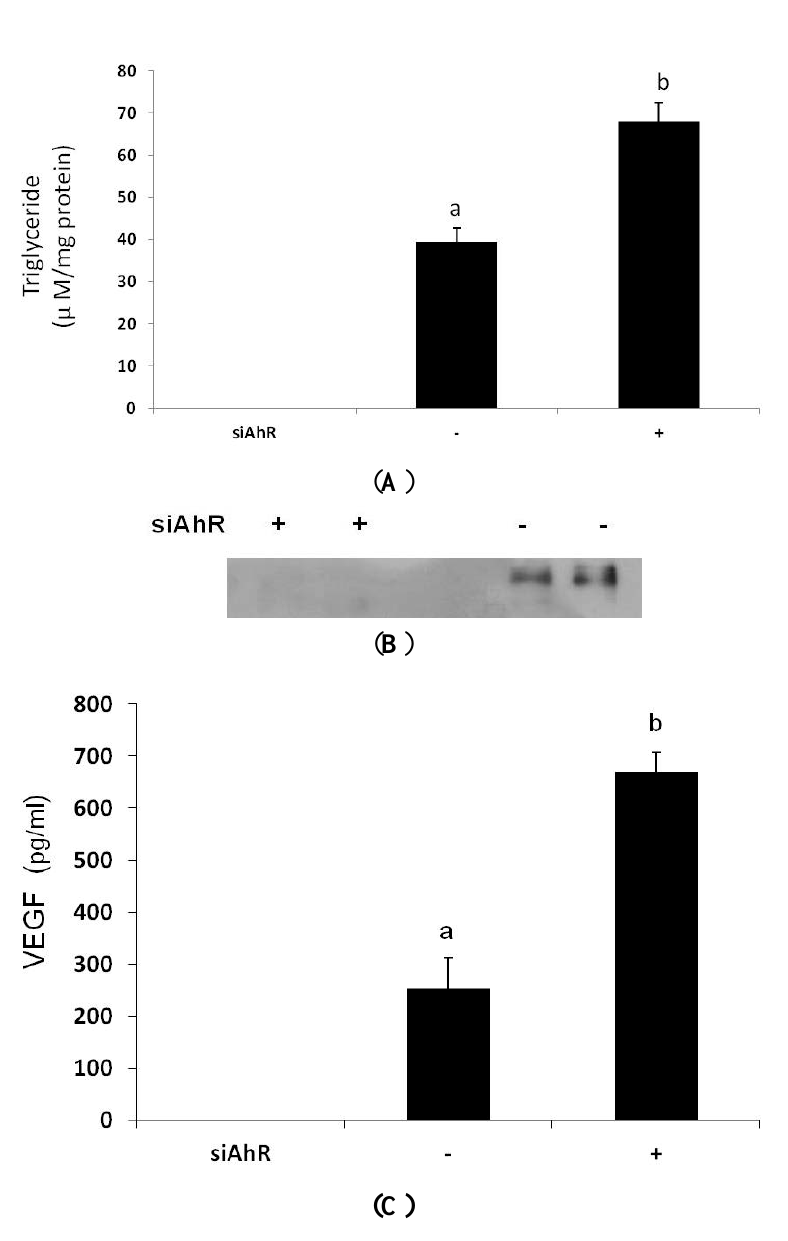
Figure 6 . Effects of knocking out the aryl hydrocarbon receptor (AhR) on expression of the AhR ( A ), intracellular triglyceride accumulation ( B ), and vascular endothelial growth factor (VEGF) secretion by mature adipocytes. 3T3-L1 preadipocytes were transfected with siRNA for the AhR, and cells were cultivated in differentiating medium to obtain mature adipocytes. Expression of the AhR by mature adipocytes was determined by a Western blot analysis. Intracellular triglyceride (TG) contents and VEGF released into the medium were analyzed by commercial assay kits. Pictures are representative of three independent experiments. Values are the mean ± SD from three measurements. Data with different letters significantly differ ( p <